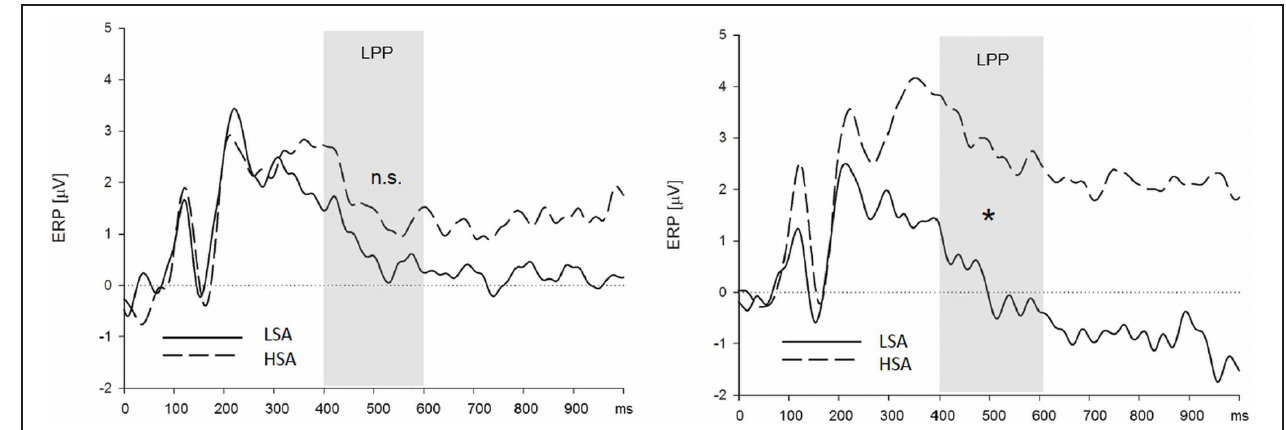
FIGURE 5 | High socially anxious individuals (HSA) showed larger LPPs in response to faces presented in the context of chemosensory anxiety signals (right side) than did low-socially anxious individuals (LSA). There